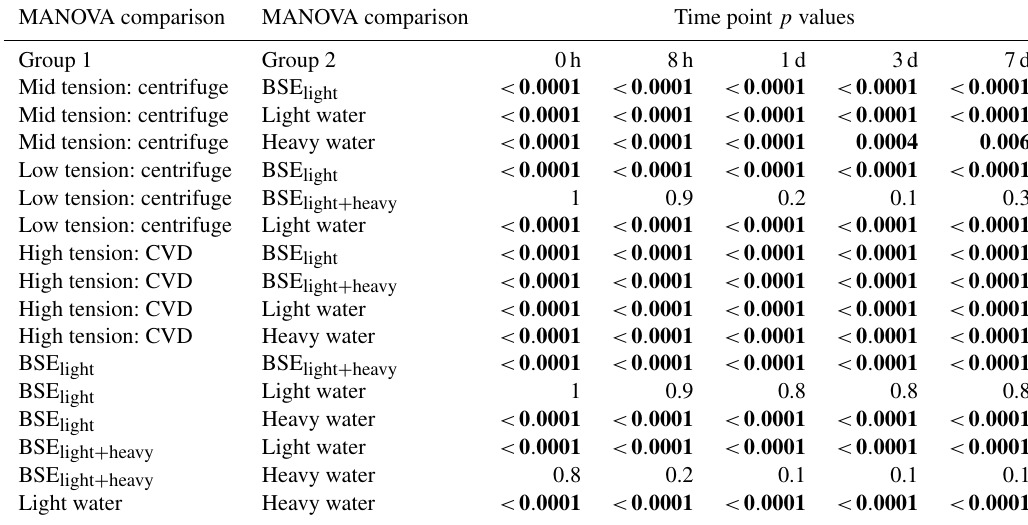
Table A1. The p value results of pairwise MANOVA tests for the experiment with comparisons between groups of samples; group 1 compared to group 2 is shown in the respective rows. Significant values are highlighted in bold ( p value ≤ 0 . 05). This table shows the comparisons not displayed in Table